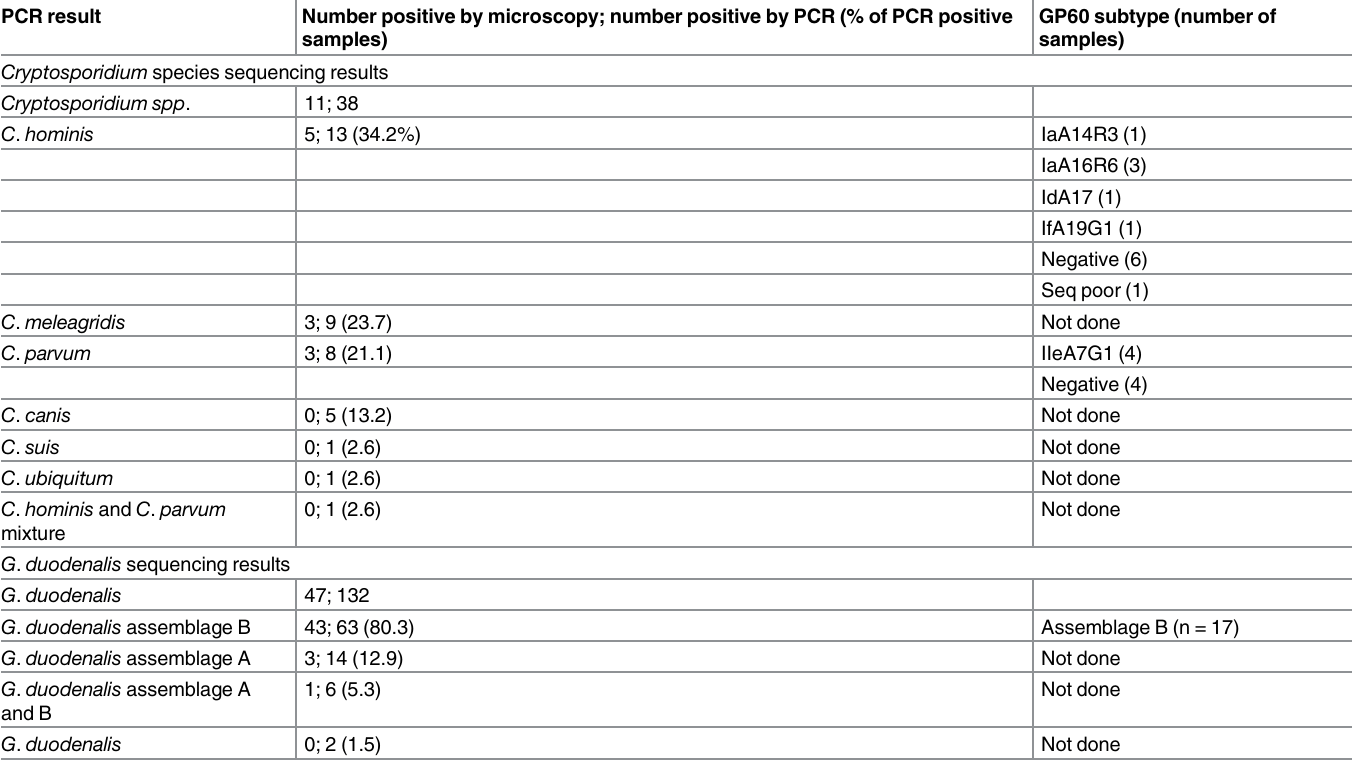
Table 3. Cryptosporidium and Giardia PCR and sequencing results. This excludes 11 samples that were positive for G . duodenalis by microscopy, but negative by PCR. PCR